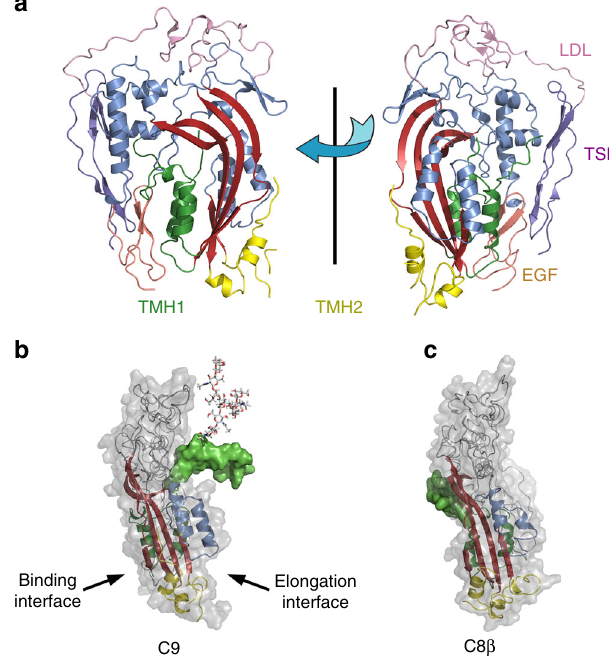
Fig. 1 The X-ray crystal structure of complement component 9. a The X-ray structure of C9 shown in cartoon in two orientations, rotated 180° apart. The bent β -sheet of the MACPF domain is shown in red with α -helices in blue, TMH1 (green) and TMH2 (yellow). The ancillary domains: TSP1 (purple), LDLRA (pink) and EGF domain (orange). Domain colours also match the colours used to show the domain features in Supplementary Fig. 2. b Cartoon model of C9 with the modelled TMH1 loop (green surface) and N-glycan (PDB ID 1HD4) located on the elongation face of the protein. The key features of the MACPF domain are shown as cartoon and coloured as follows: central β -sheet (red), TMH 1 (green), TMH2 (yellow), HTH (blue). c The C8 β structure in the same orientation as C9 showing